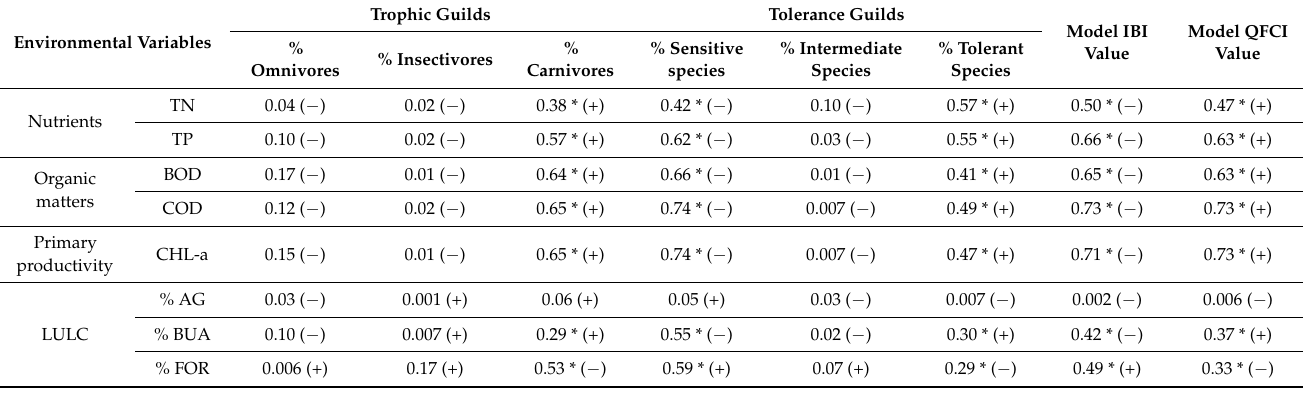
Table 1. Coefficients of determination (R 2 ) for regressions among LULC, nutrients, organic matter, algal chlorophyll with trophic and tolerance guilds and model IBI and QFCI value in the Geum River (* indicates significant at p < 0.05; (+) indicates the relationship is positive; and ( − ) indicates it is negative; TN, total nitrogen; TP, total phosphorus; BOD, biological oxygen demand; COD, chemical oxygen demand; CHL-a, chlorophyll-a; LULC, land-use land-cover; % AG, percentage of agricultural coverage; % BUA, percentage of built-up area; % FOR, percentage of forest coverage).